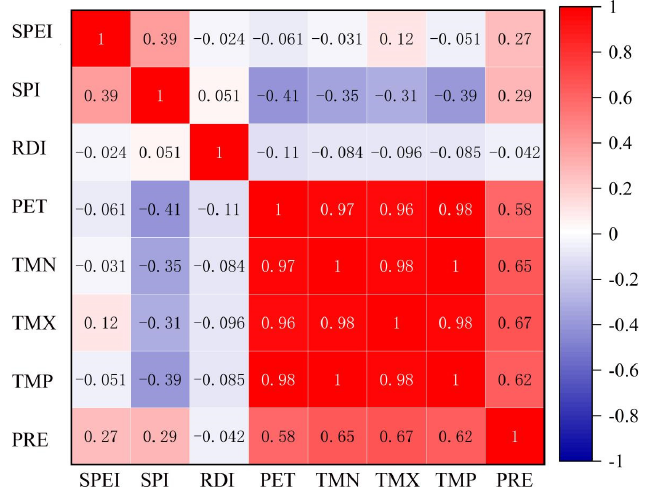
Figure 10. Correlation between different meteorological factors and drought index (PET: Potential Evapotranspiration; TMN: Minimum temperature; TMX: Maximum temperature; TMP: Mean temperature; PRE: Precipitation).